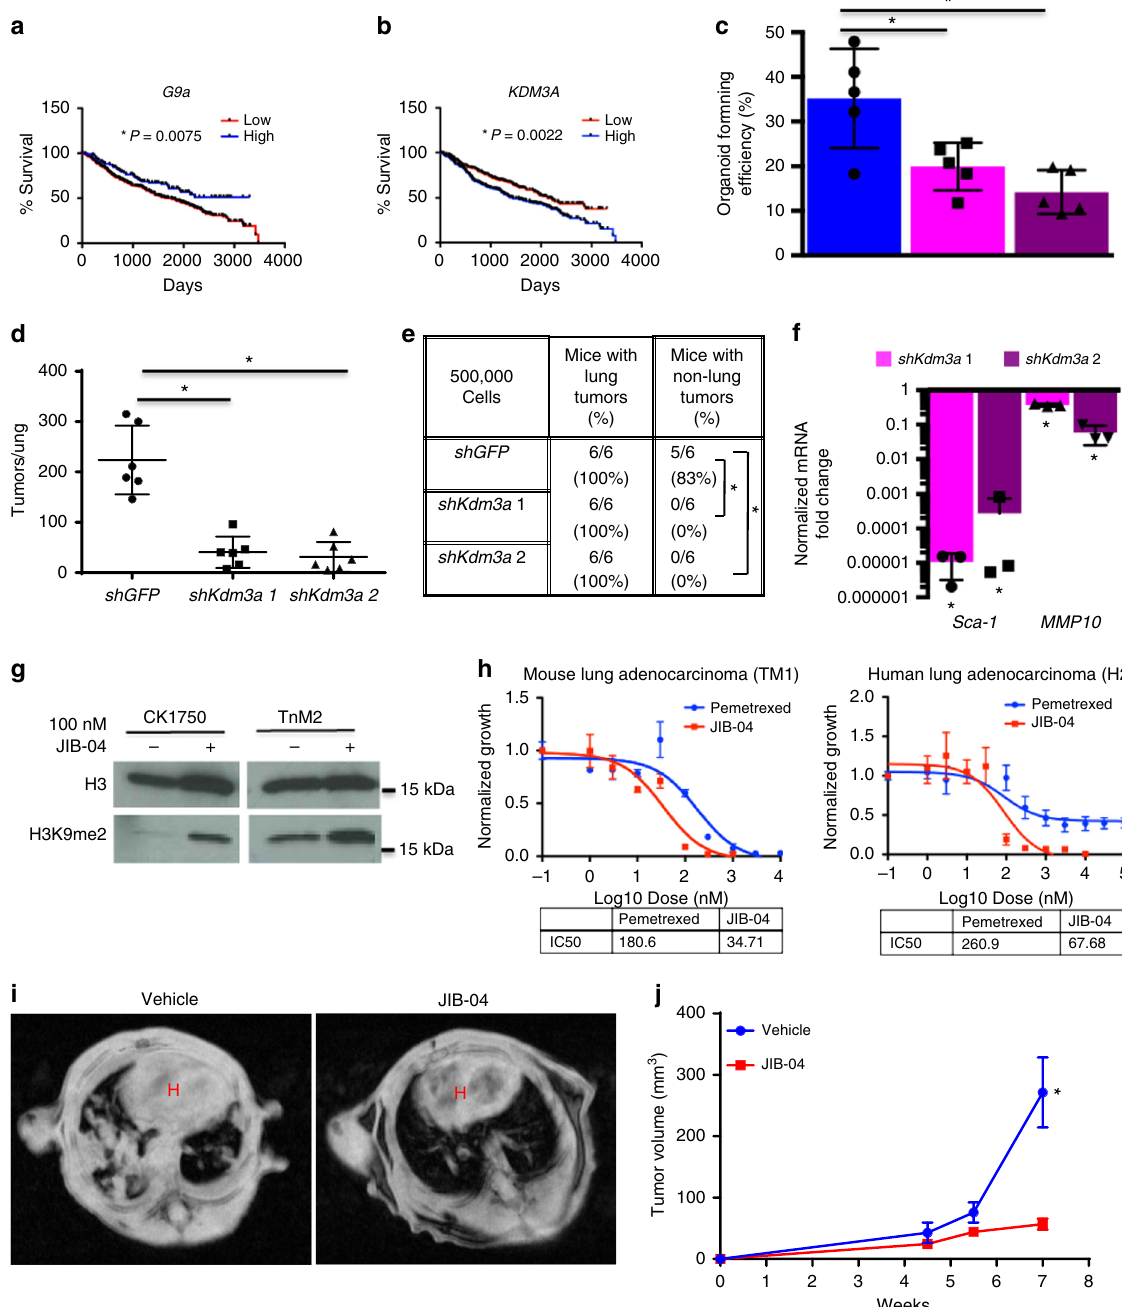
Fig. 4 Antagonizing H3K9 KDMs represses TPC phenotypes. a , b Kaplan – Meier curves of 10-year survival of patients from the director ’ s challenge cohort of early stage lung adenocarcinoma. Populations sorted for high and low expression of a H3K9me1/2 G9a and b H3K9me1/2 demethylase KDM3A. * P < 0.05, Mantel – Cox log-rank test. c Bar chart of % of cells forming organoids 10 days after 1000 shGFP and shKdm3a CK1750 adenocarcinoma cells were plated in 3D culture. Error bars denote standard deviation. * P < 0.05, Fisher ’ s t test, n = 4. d Chart of average number of tumors per H&E-stained section from recipients of intravenously transplanted shGFP and shKdm3a adenocarcinoma cells. * P < 0.05, Mann – Whitney test. e Table of transplanted mice with lung and non-lung tumors. * P < 0.05, Fisher ’ s exact test. f Bar chart of fold change of Gapdh -normalized mRNA levels of indicated genes in shKdm3a adenocarcinoma cells over shGFP control cells. Error bars denote standard deviation. * P < 0.05, Fisher ’ s t test, n = 3. g Western blot of whole cell lysates from CK1750 adenocarcinoma cells treated with either 100 nM JIB-04 or DMSO for 96 h, and then immunoblotted for the indicated antibodies. h Representative dose – response curve of mouse (TM1) and human (H23) NSCLC cells grown for 96 h with JIB-04 or Pemetrexed, normalized to growth with vehicle control. i Representative MR images of allograft mice treated with vehicle or JIB-04 at 7 weeks post transplantation. H indicates heart area. j Chart of average tumor volume of allografted mice treated with either vehicle or JIB-04. * P < 0.05, Fisher ’ s t